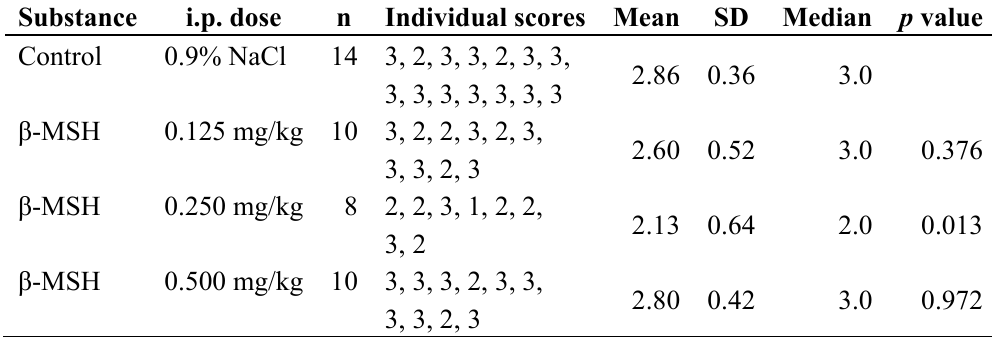
Table 3. Descriptive statistics (macroscopic inflammation score, 0–3 scale) in experimental model of colitis. p value is a result of comparison with the control group (Steel’s